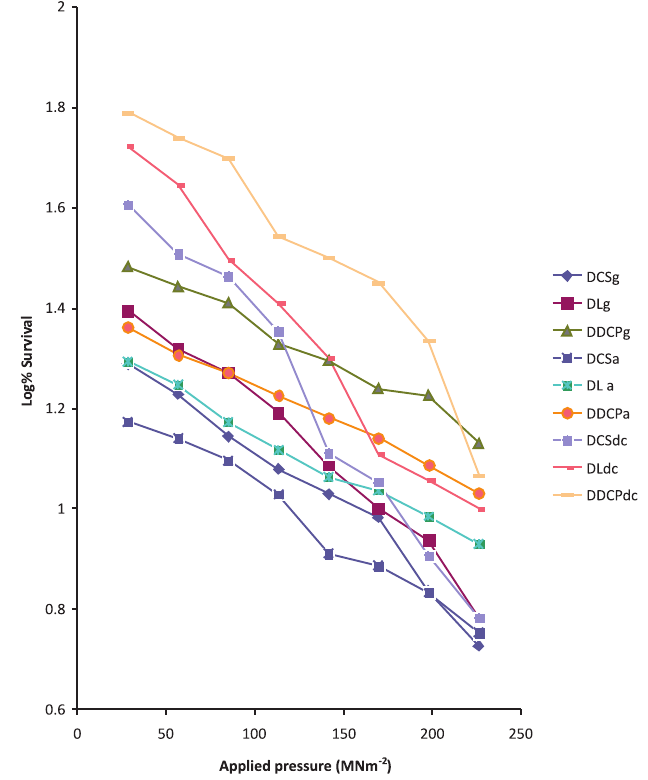
FIGURE 4 - Log% survival versus applied pressure,